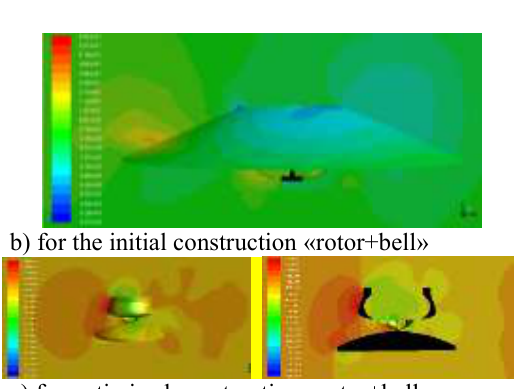
Figure 2. WP construction of optimized bell with rotor.